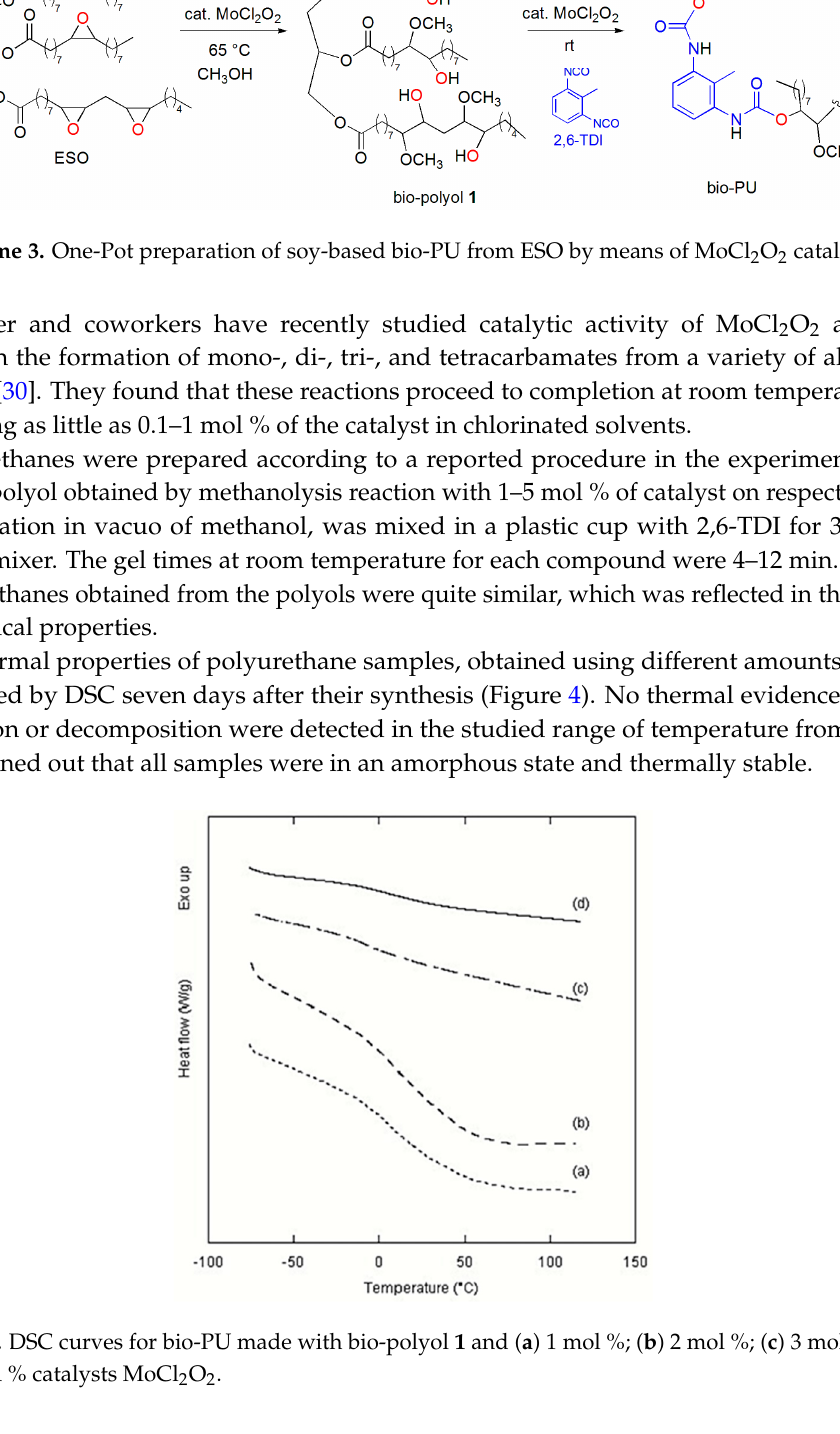
Figure 4. DSC curves for bio-PU made with bio-polyol 1 and ( a ) 1 mol %; ( b ) 2 mol %; ( c ) 3 mol % and ( d ) 5 mol % catalysts MoCl 2 O 2 .